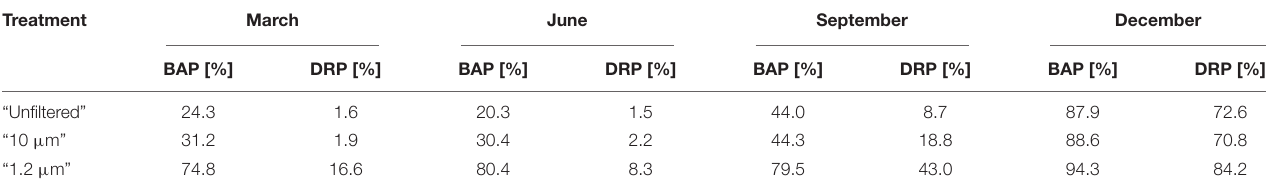
TABLE 8 | Bioavailable phosphorus (BAP) and dissolved molybdate-reactive phosphorus (DRP) as an amount of the total phosphorus (TP) differentiated via the different treatments and experiments based on respective median values.